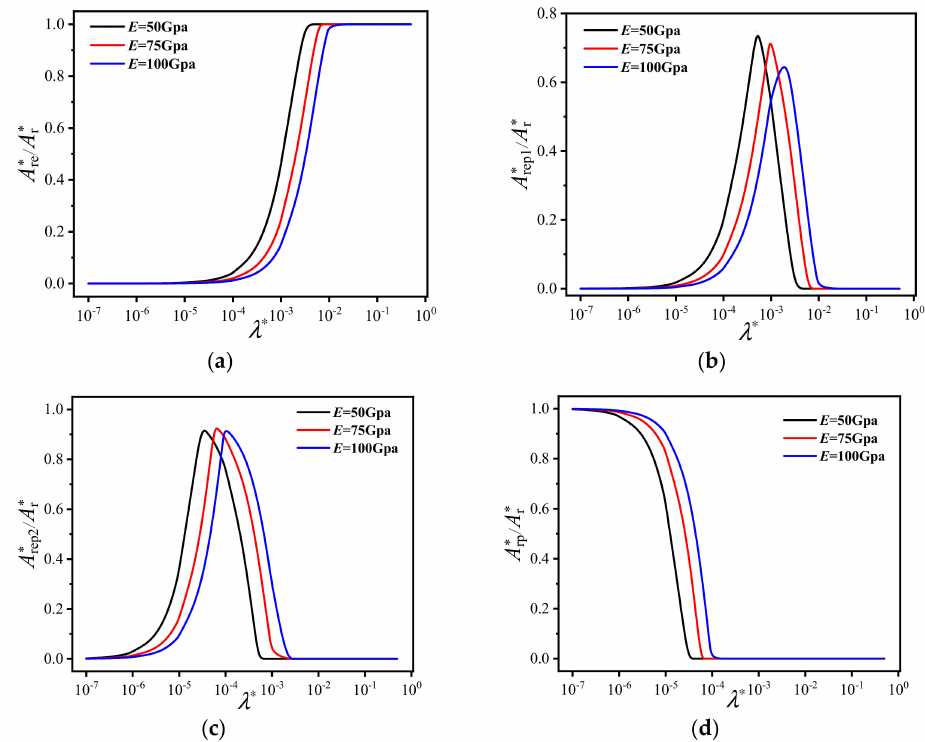
Figure 11. Influence of equivalent modulus of elasticity E on multilength contact characteristics. ( a ) Proportion of elastic contact area versus λ *. ( b ) Proportion of elastoplastic contact area in the first stage versus λ *. ( c ) Proportion of elastoplastic contact area in the second stage versus λ *. ( d ) Proportion of plastic contact area versus λ